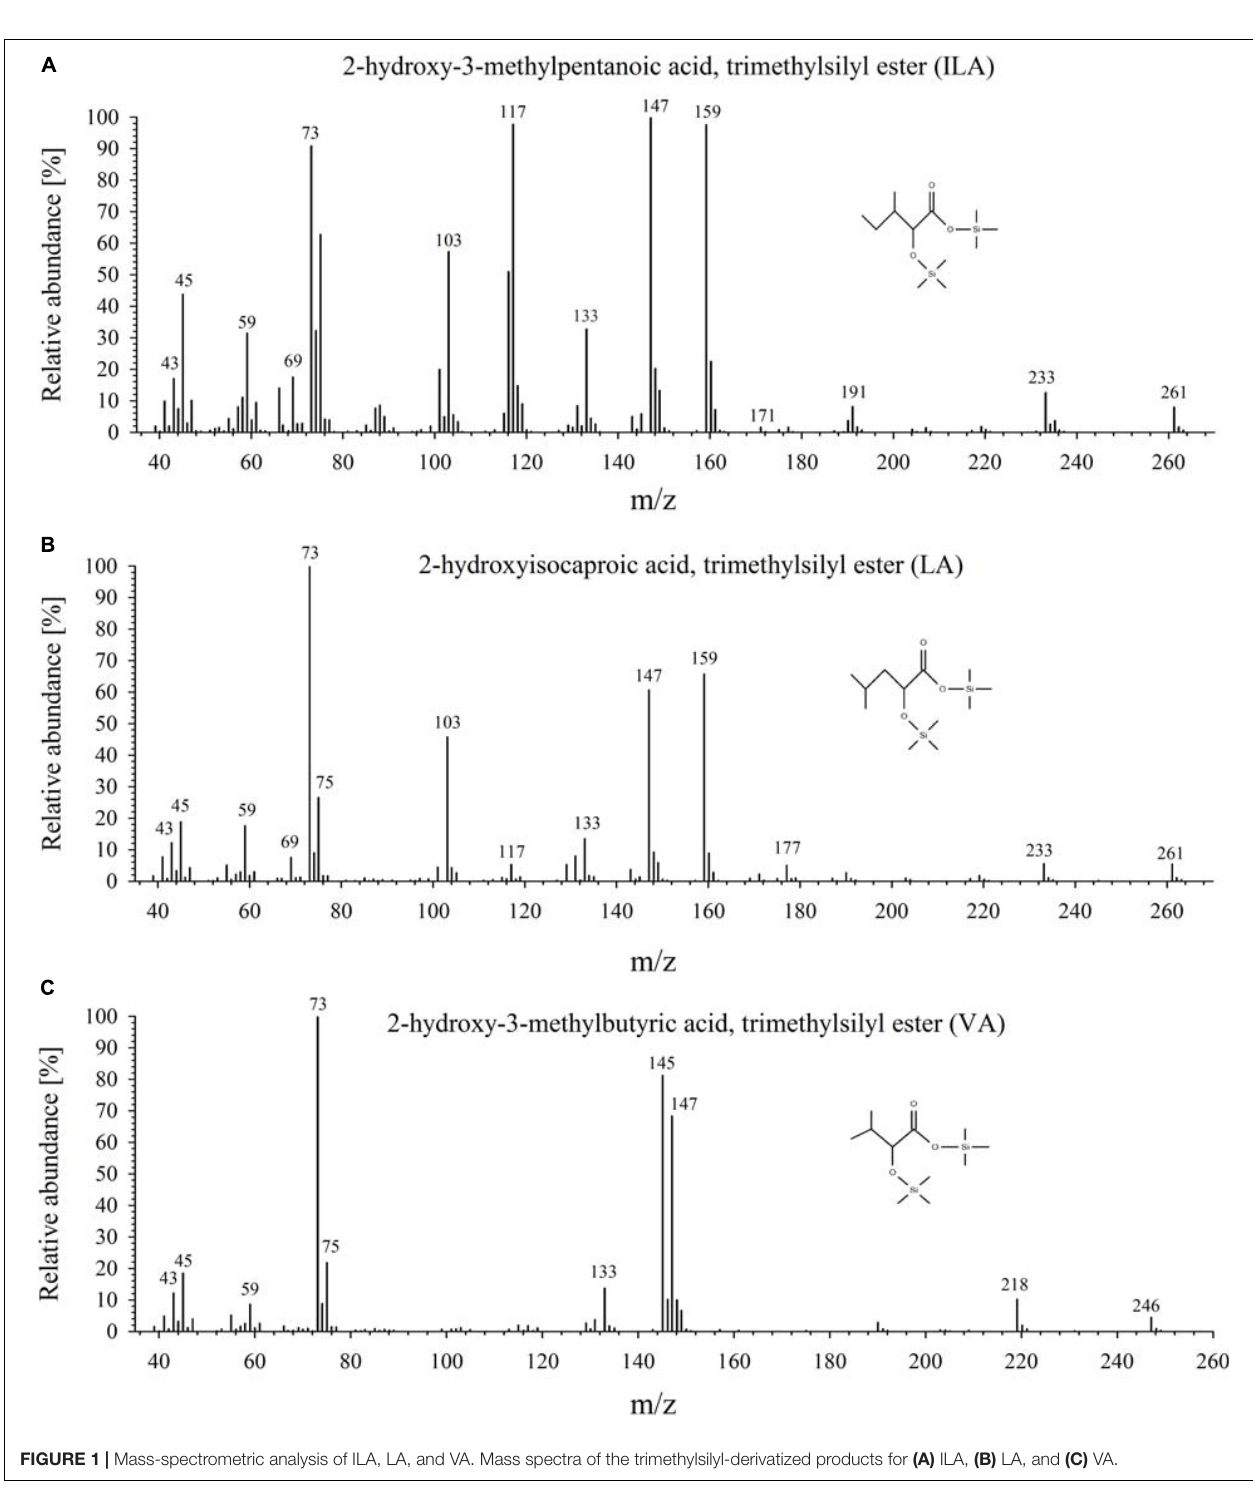
acid: start time: 13.9 min, ion: 173.1 m/z, dwell: 100 ms;